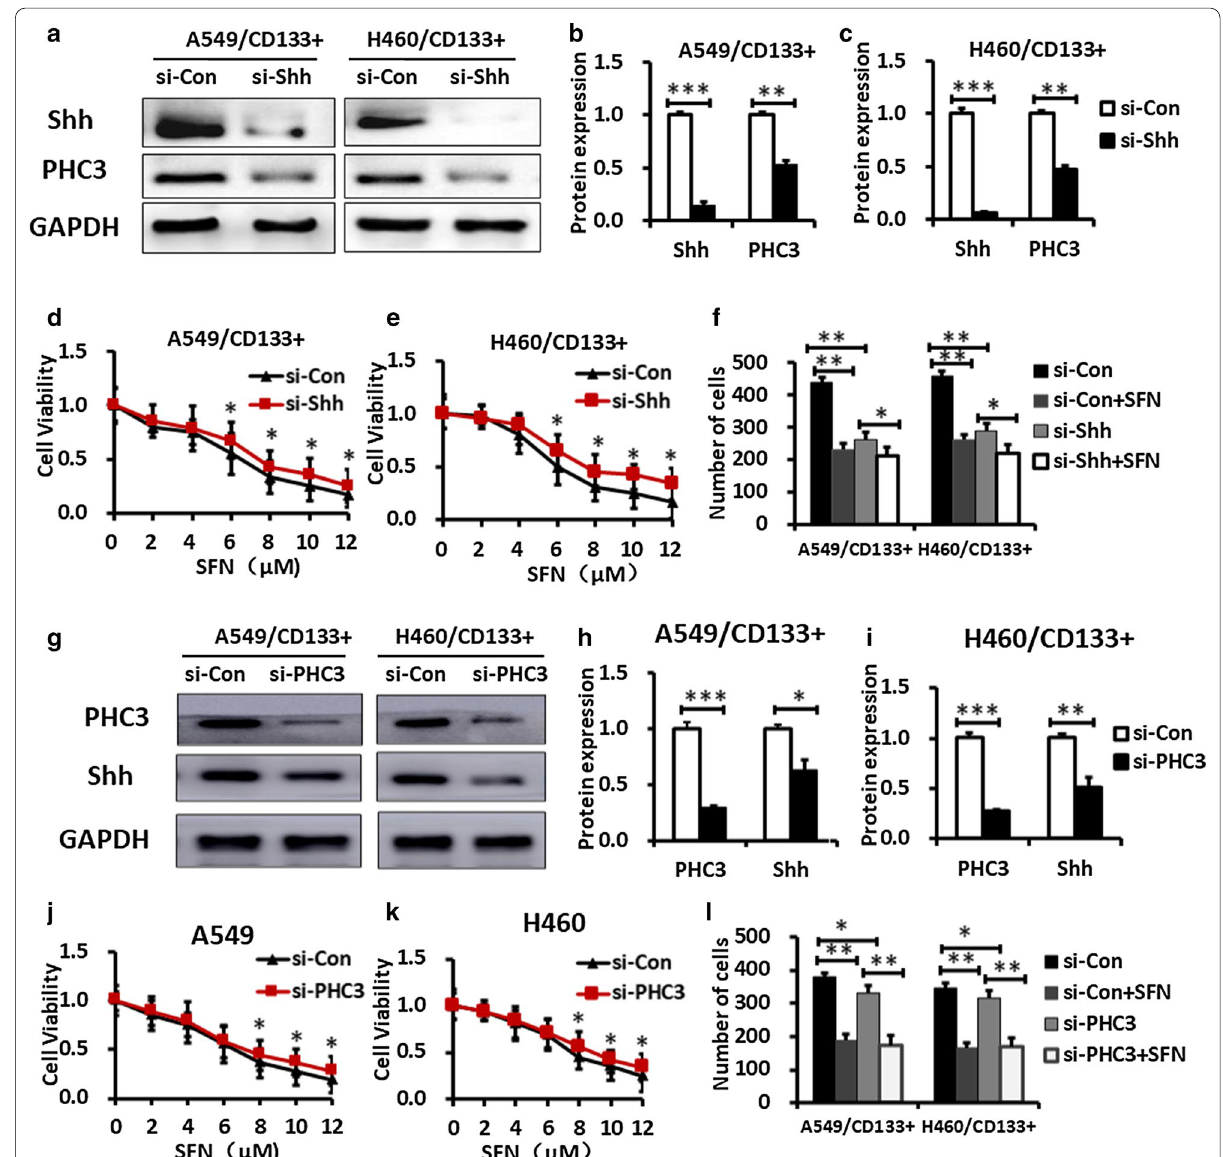
Fig. 4 SFN regulates self-renewal of lung CSCs through SHH Signaling Pathway and PHC3. a – c The efficiency of siRNA to silence Shh gene were determined by Western blotting. The relative protein levels were quantified with Image J software. d , e SFN inhibited cell viability of siRNA-Shh group less than that of si-control group when SFN concentration was 6, 8, 10 and 12 μmol/L. f Cell numbers of siRNA-Shh cells are significantly less than that of si-control group. And the inhibitory effect of SFN on siRNA-Shh cells are significantly lower than that of si-control group. g – i The efficiency of siRNA to silence PHC3 gene were determined by Western blotting. The relative protein levels were quantified with Image J software. j , k SFN inhibited cell viability of siRNA-PHC3 group less than that of si-control group when concentration was 8, 10 and 12 μmol/L. l Cell numbers of siRNA-PHC3 cells are significantly less than that of si-control group. And the inhibitory effect of SFN on siRNA-PHC3 cells are significantly lower than that of si-control group. N 3, Data are presented as mean SD, *P < 0.05, **P < 0.01, ***P < = ±